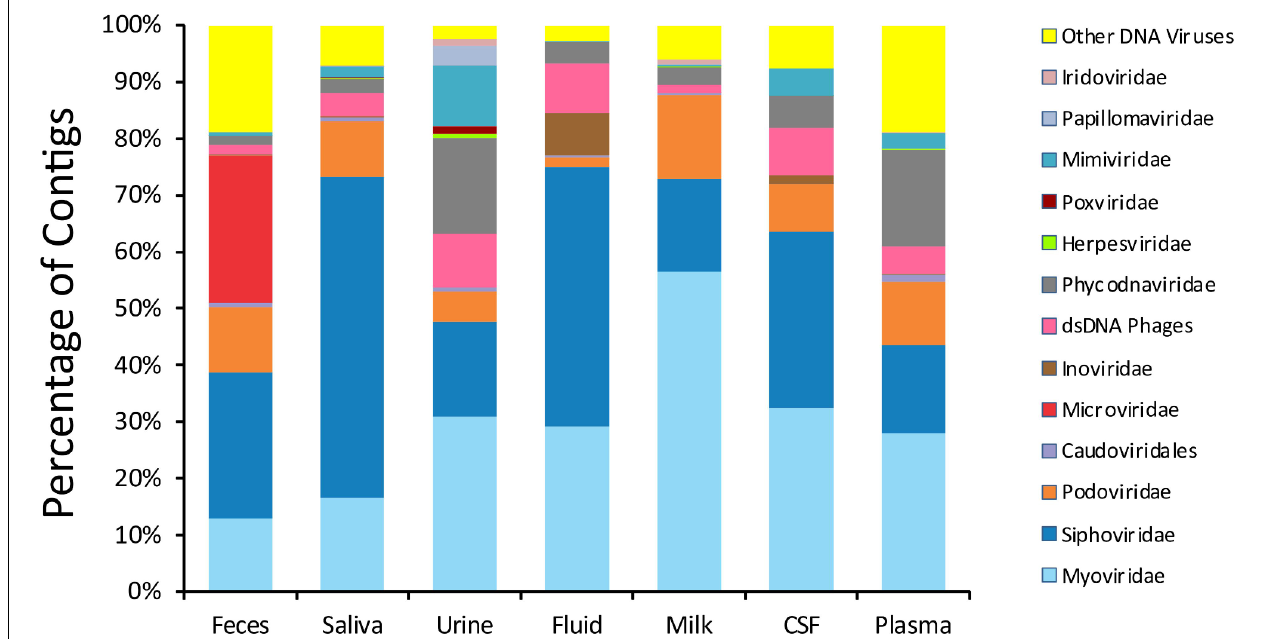
FIGURE 1 | Proportion of viral contigs with TBLASTX hits to the specified virus families. The y-axis represents the percentage of contigs homologous to each family, or that were unclassified dsDNA phages or other viruses. The sample type is shown on the x-axis. The percentage of reads was determined based on the raw number of reads used to assemble each